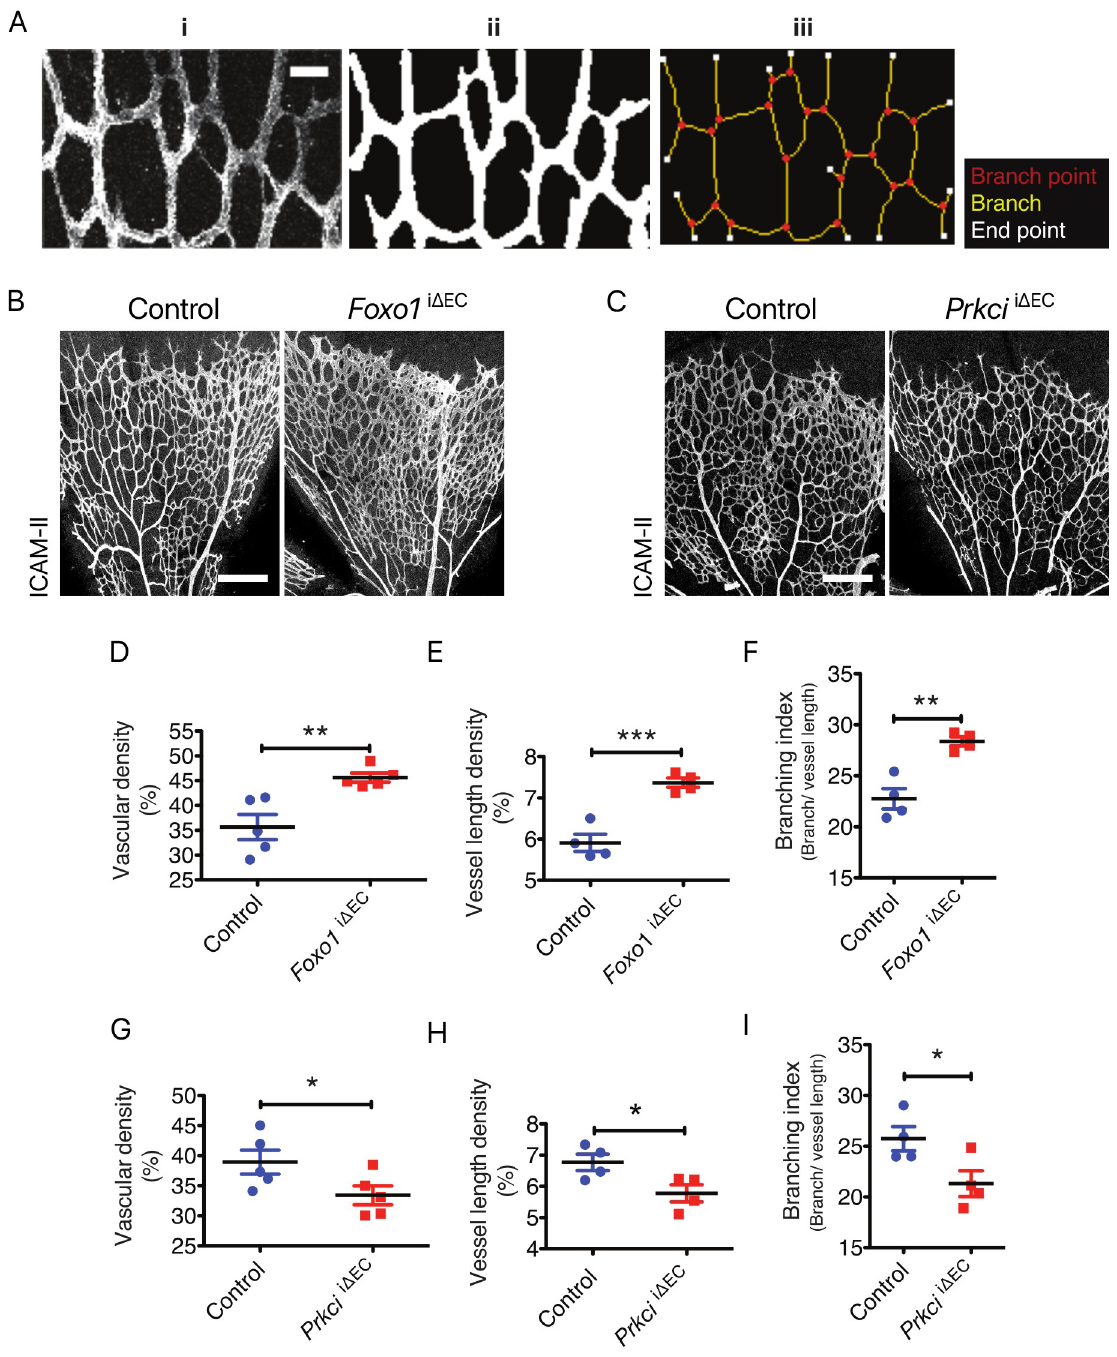
Fig 1. Characterization of the hyper- and hypo-branching vascular models. A) Grayscale image of a sample subset of the retinal microvasculature stained for ICAM-II (i), converted into the vessel mask (ii) and used for skeleton analysis (iii); Scale bar represents 30 μ m. B) Staining of ICAM-II in control and Foxo1 i Δ EC mouse retinae at postnatal day 5 (P5); Scale bar represents 200 μ m. C) Staining of ICAM-II in control and Prkci i Δ EC mouse retinae at P5; Scale bar represents 200 μ m . D) Quantification of vascular density (percentage of area occupied by vessels), E) vessel length density (percentage of area occupied by skeletonized vessel) and F) branching index (branch point/ mm of vessel length) in control and Foxo1 i Δ EC retina at P5. G) Quantification of vascular density, H) vessel length density and I) branching index in control and Prkci i Δ EC mouse retinae at P5. Data represent mean ± S.E.M. two-tailed unpaired t-test � p < 0.05, �� p < 0.01, ��� p < 0.001 (n = 5 for D and G, n = 4 for E, F, H and I).